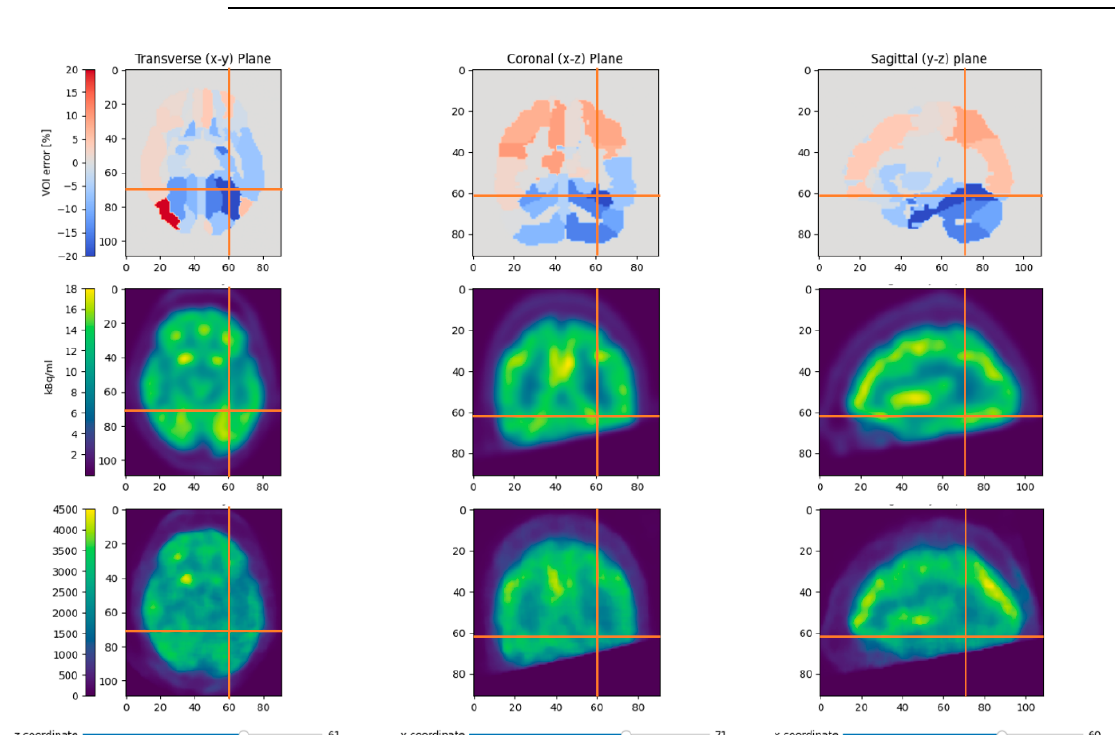
Figure 12. This figure shows the relative VOI deviations for patient P1 with the patient-specific attenuation map in the first row. The middle row shows the smoothed reference PET and the last row the median-filtered BPET reconstruction. Most regions with the largest errors (left cerebellar hemisphere and left fusiform gyrus) were near the area that was outside the BPET field of view due to inaccurate positioning of the patient.